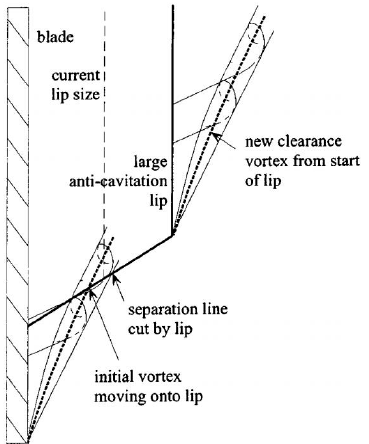
Figure 36. Sketch of leakage vortex with a large anticavitation lip [83].